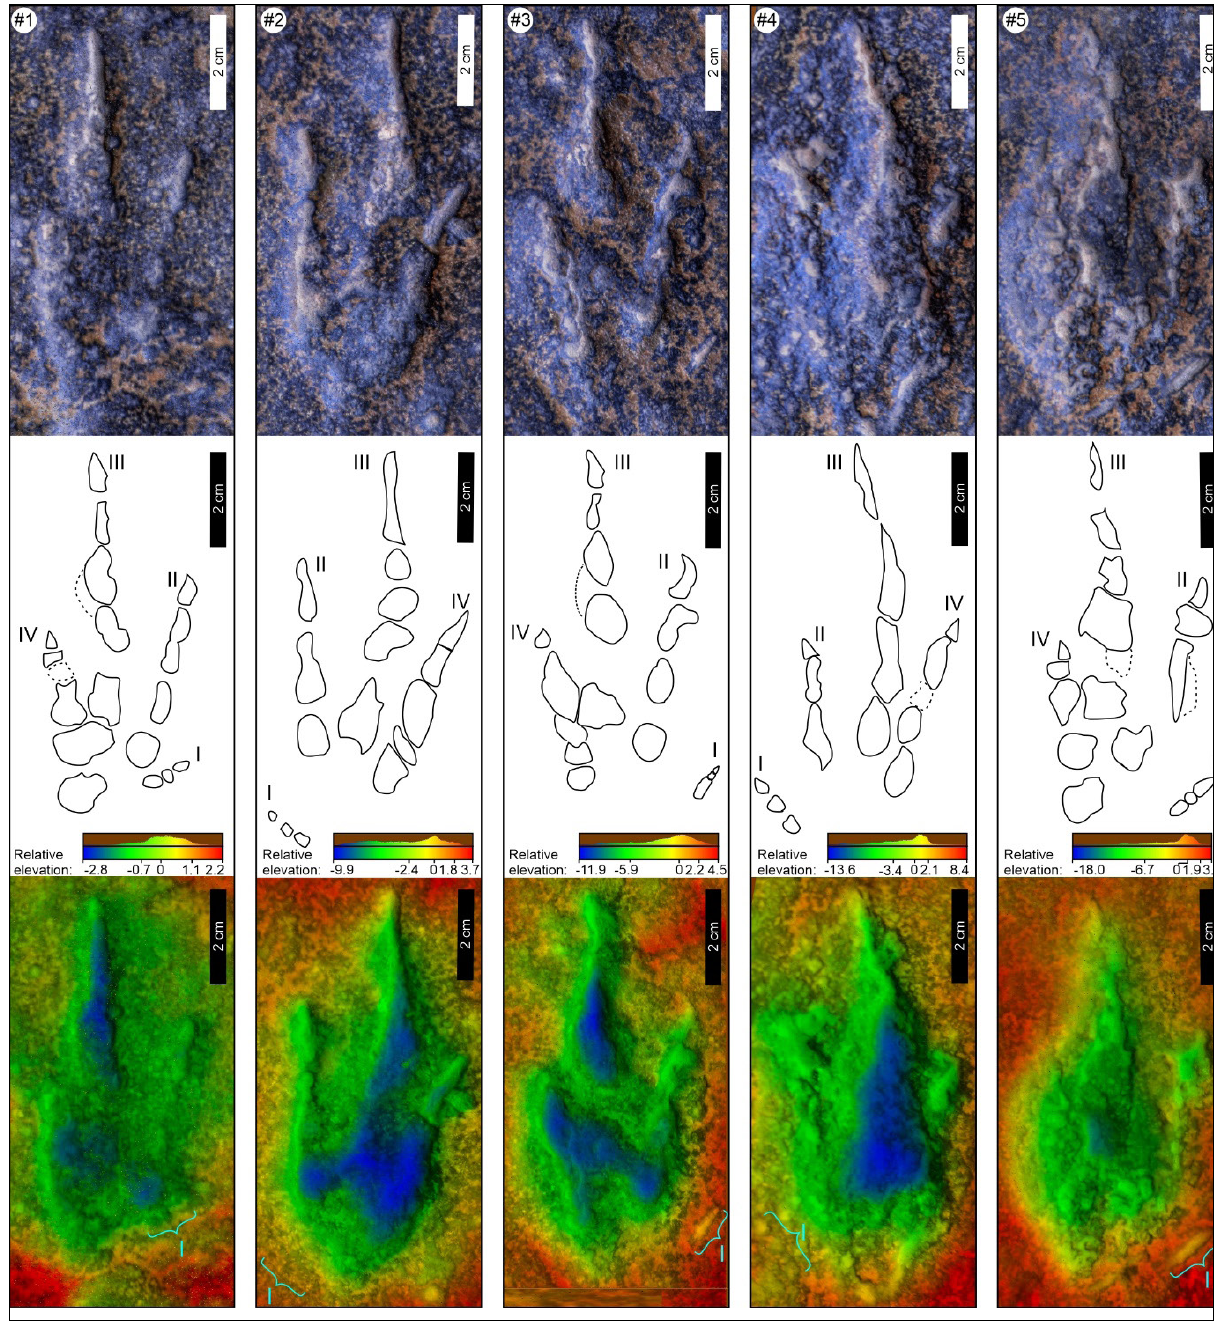
Figure 3: Five Grallator tracks from the lower Clarens Formation at the Storm Shelter ichnosite. Each track (#1–#5) is illustrated with three different images: top – orthophoto derived from photogrammetric model; middle – interpretive outline drawing; bottom – false-colour depth map (dark red is the highest point; blue is the lowest). See Supplementary table 1 for track morphometric measurements and https://doi.org/10.6084/ m9.figshare.13007240 for the photogrammetric models. Roman numerals I–IV denote digits; for clarity, the length of digit I is marked with curly brackets on the false-colour depth